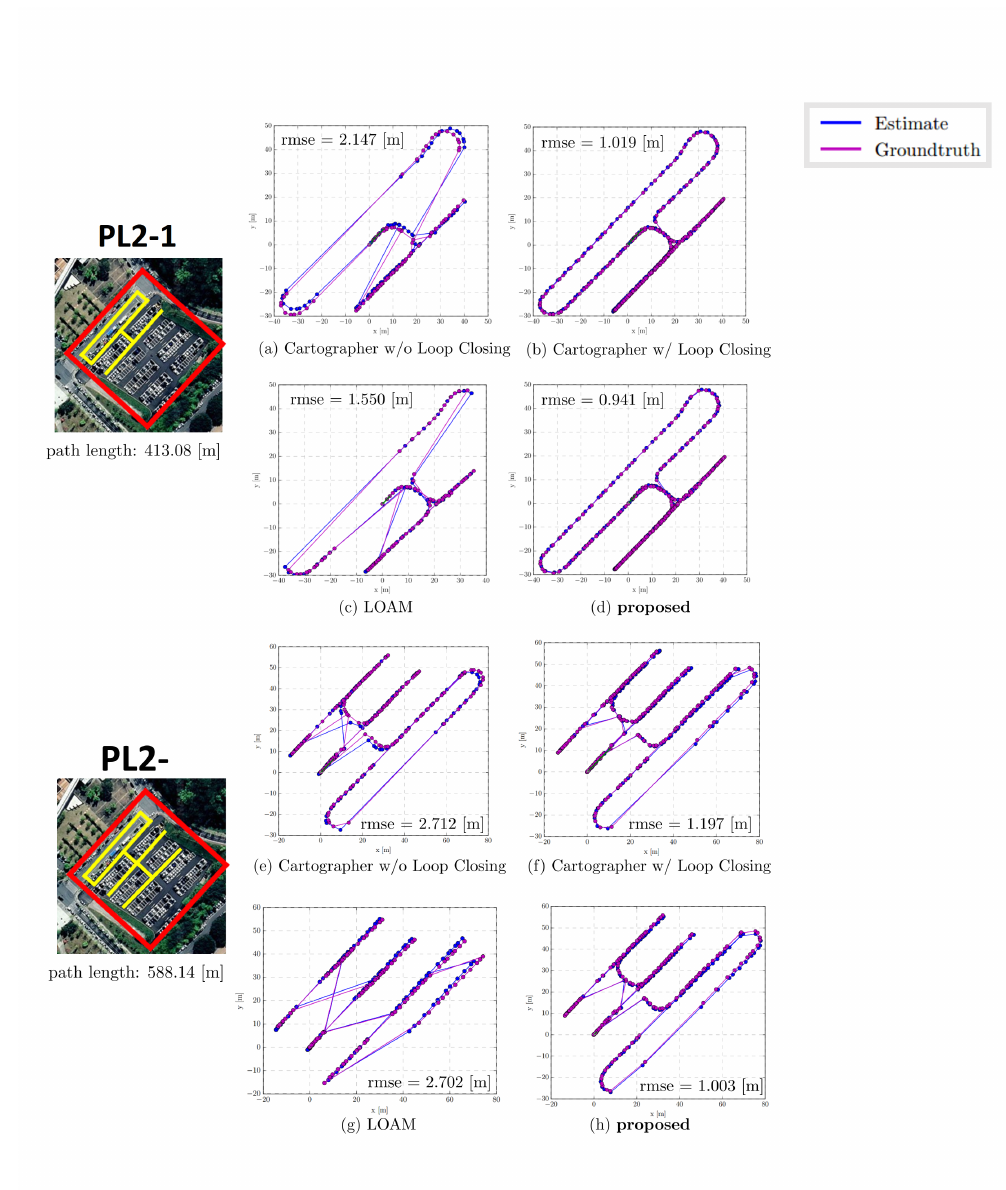
Figure 14. Illustration of SLAM trajectory evaluation. Experiments were conducted in the outdoor parking lot PL2-1 and PL2-2. In the case of ( c , g , h ), the timestamp matching occurs sparsely, and the path appears relatively